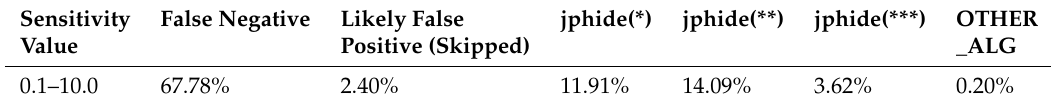
Table 3. Rate of sensitivity results from 500 seam-carve untouched